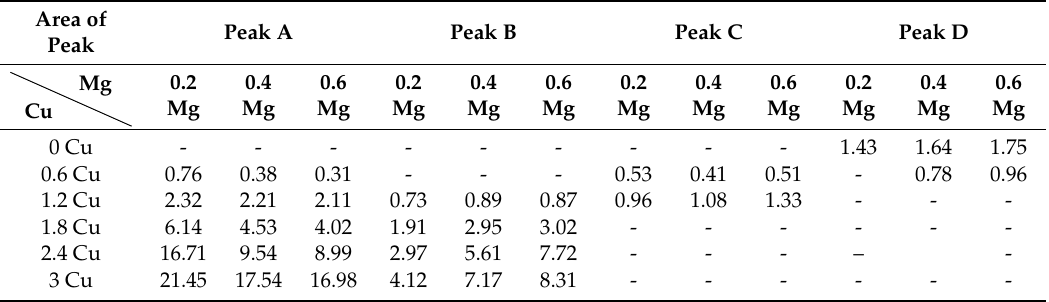
Table 5. The influence of the evolution of Cu and Mg composition (wt%) on t he area of each endothermic peak (J / g).